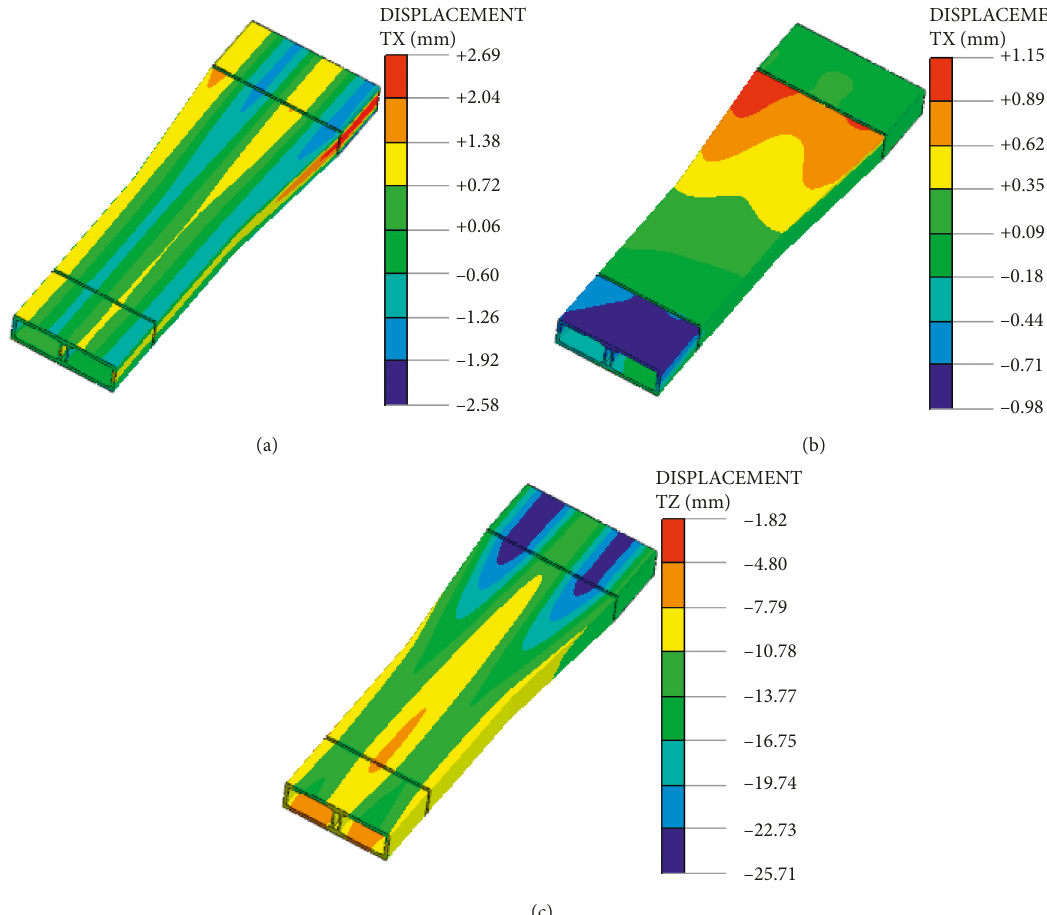
Figure 19: The nephogram of the displacement of segment E1 under working condition 12: (a) x -direction; (b) y -direction; (c) z -direction.